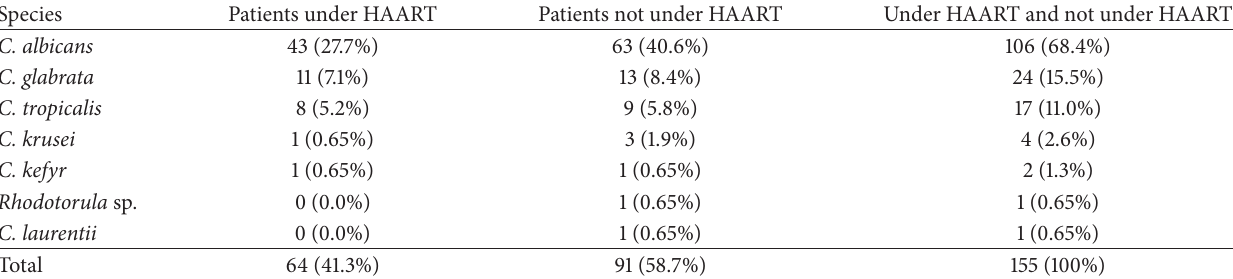
Table 4: Distribution of yeast isolates in HIV patients with OPC under HAART and not under HAART ( 𝑛 = 155 ).